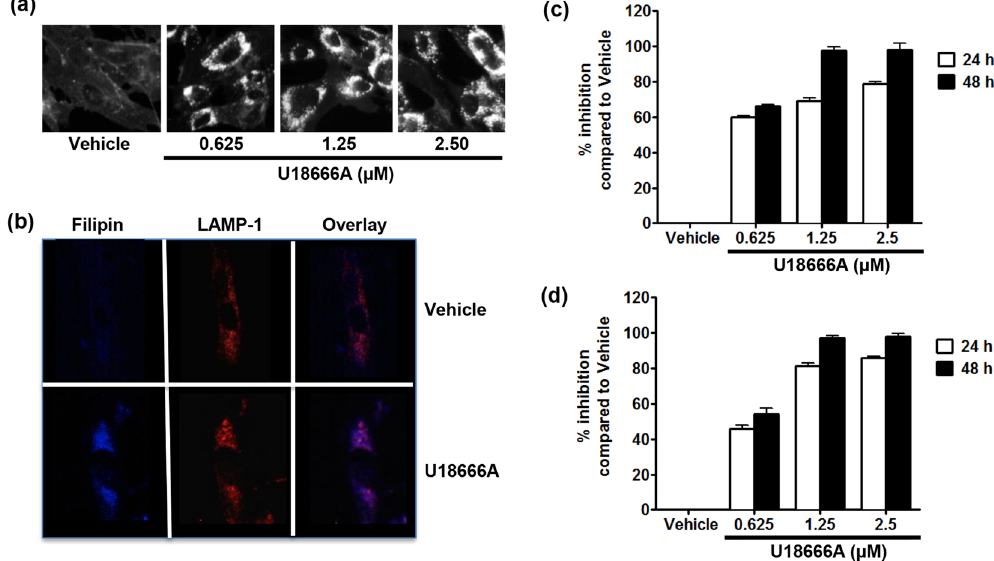
Figure 1. U18666A causes accumulation of cholesterol in the late endosome/lysosome and inhibits CHIKV replication in human skin fibroblasts. ( a ) Human skin fibroblasts were treated either by water (vehicle) or 0.625, 1.25 and 2.5 μ M of U18666A for 24 h before fixation and labeling by filipin. ( b ) Human skin fibroblasts were treated with vehicle or 2.5 μ M of U18666A for 24 h before fixation and labeling by filipin (blue) or LAMP-1 (Red). Colocalization of cholesterol and LAMP-1 are shown in violet. ( c and d ) Human skin fibroblasts were treated with vehicle or U18666A for 24 h before infection with CHIKV La Réunion strain (MOI 1). After 24 and 48 h, virus RNA and infectious virus production were measured by real time RT-PCR and plaque assay, respectively. Inhibition at the presence of vehicle was set as “0” and percentage of inhibition at the presence of inhibitor was calculated using formula [1 − (I/V)] * 100 where V and I designate experimental values (RNA copy numbers or plaque numbers) at the presence of vehicle and inhibitor, respectively. The data represent mean ± SD from three independent